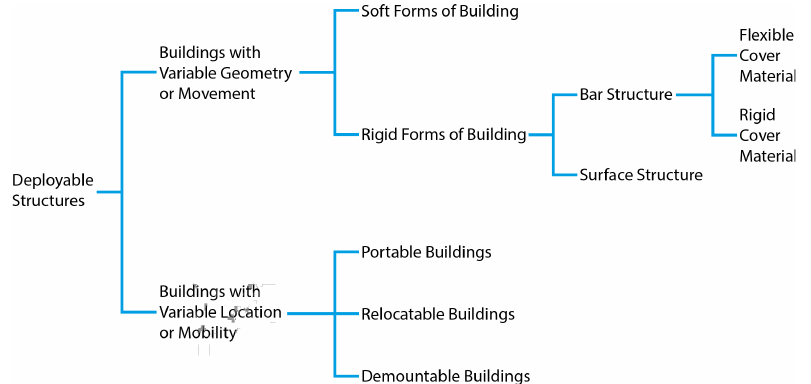
Figure 8: Classification of Korkmaz from